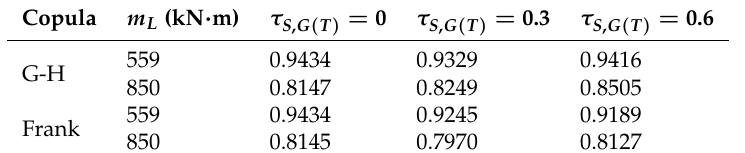
Table 2. L ( 0,22 ) associated with different τ S , G ( T ) for the case of linear deterioration.